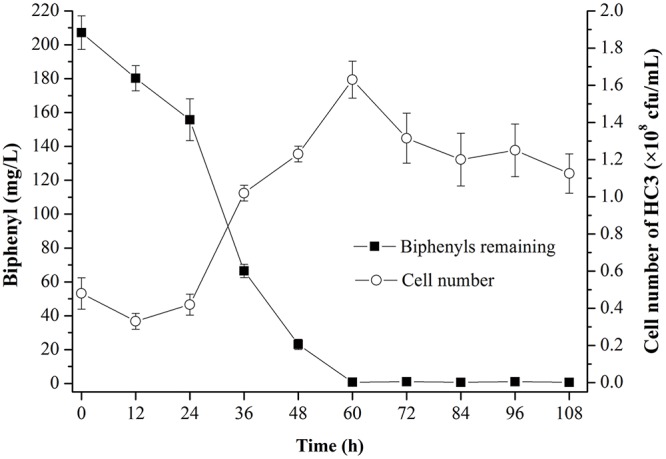
Time course of biphenyl degradation and cell growth of HC3.